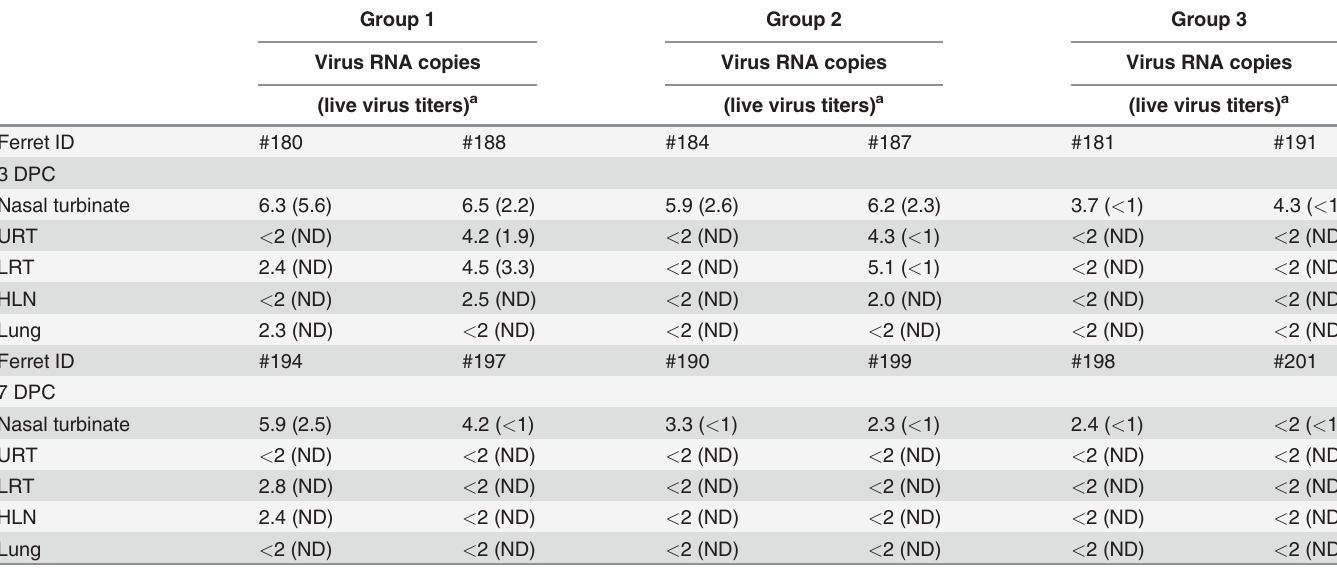
Table 2. Virus titers in vaccinated ferrets at 3 and 7 days post challenge (DPC) with wild-type in fl uenza H7N9